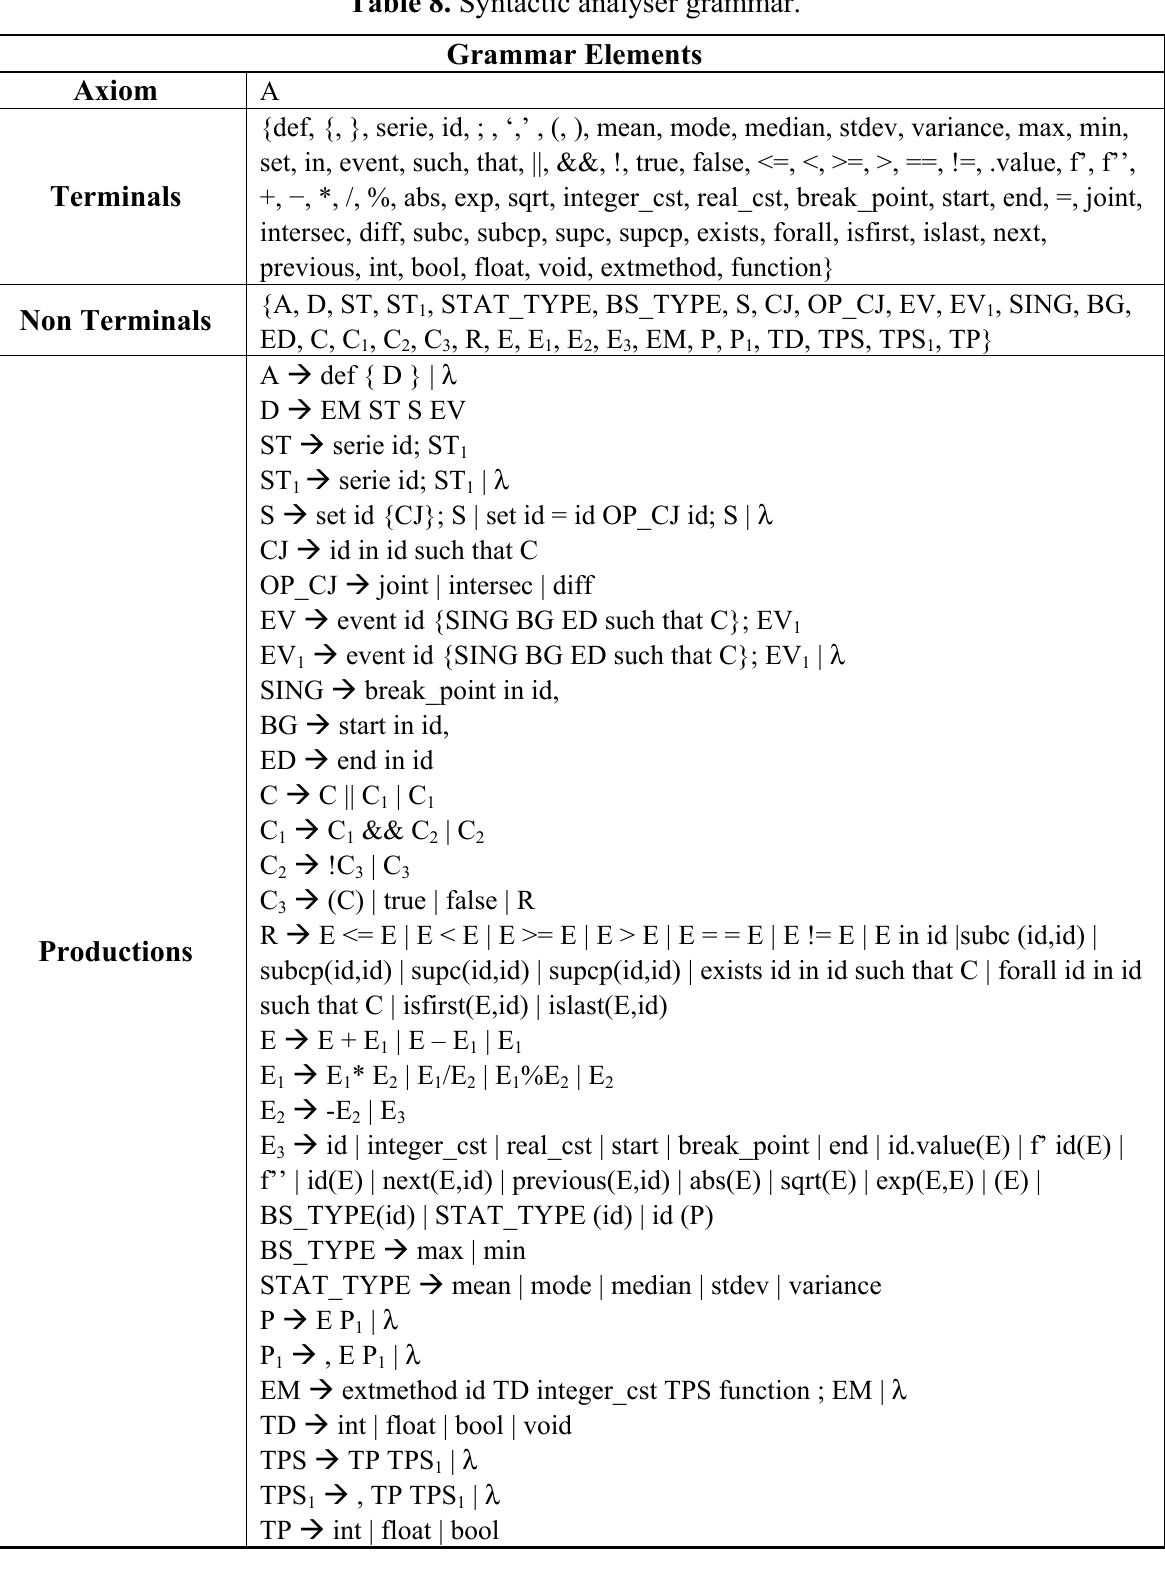
Table 8. Syntactic analyser